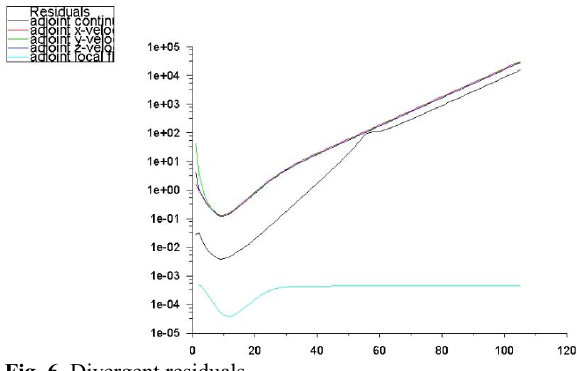
Fig. 6. Divergent residuals